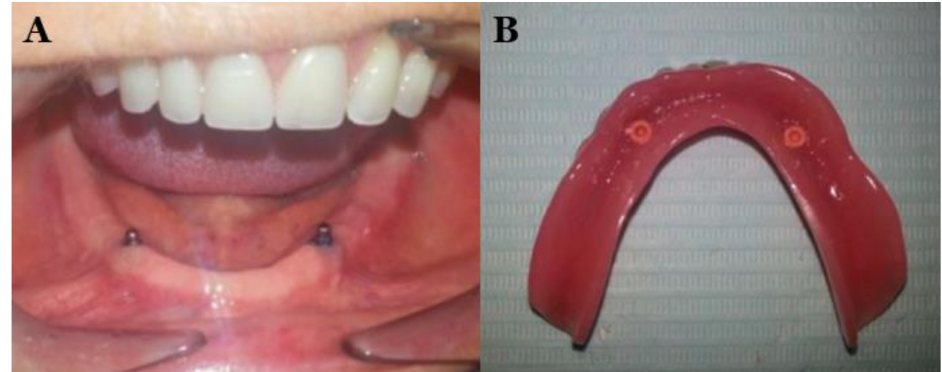
Figure 1. Ball attachment to retain overdenture ( A ) and overdenture (tissue surface) ( B ) [3].